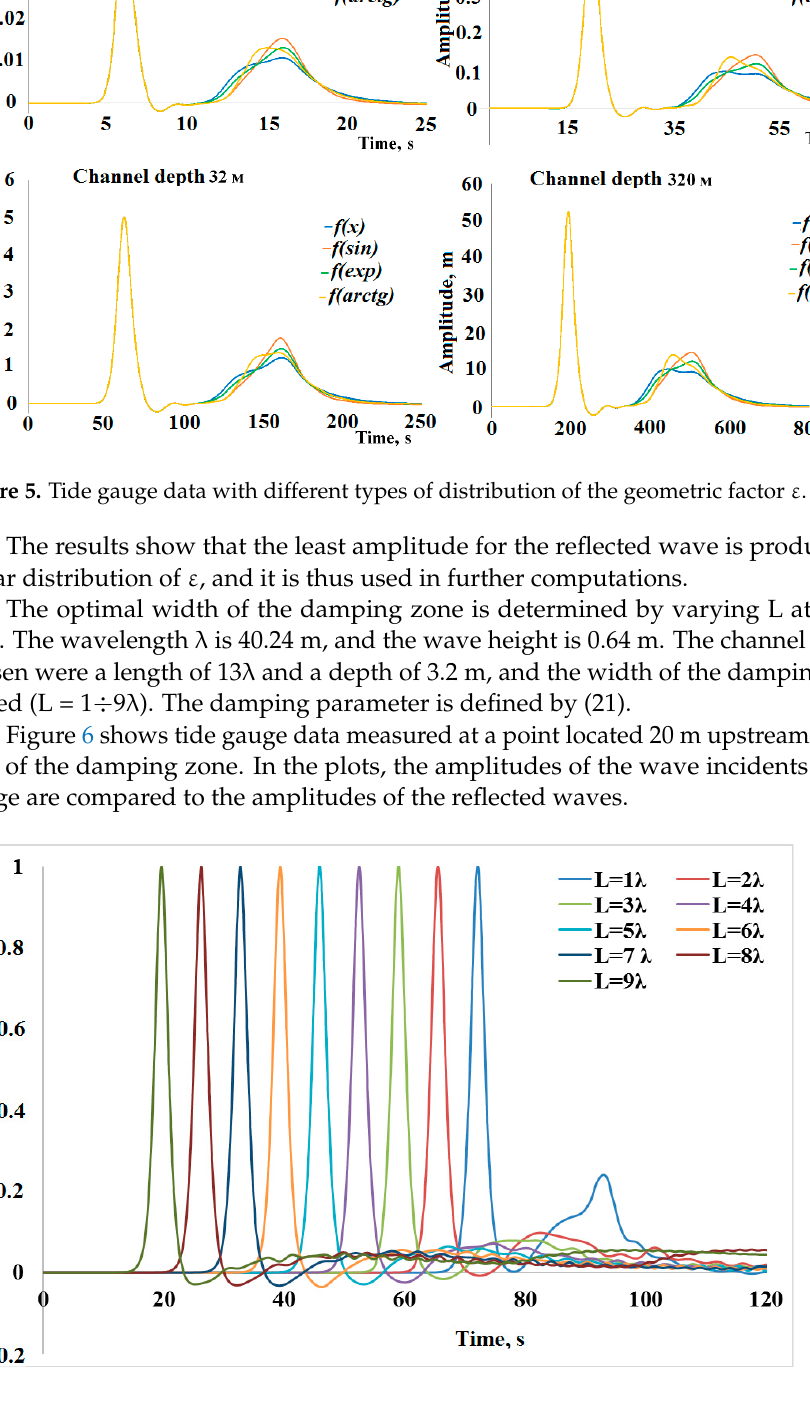
Figure 6. Incident and reflected wave amplitudes.